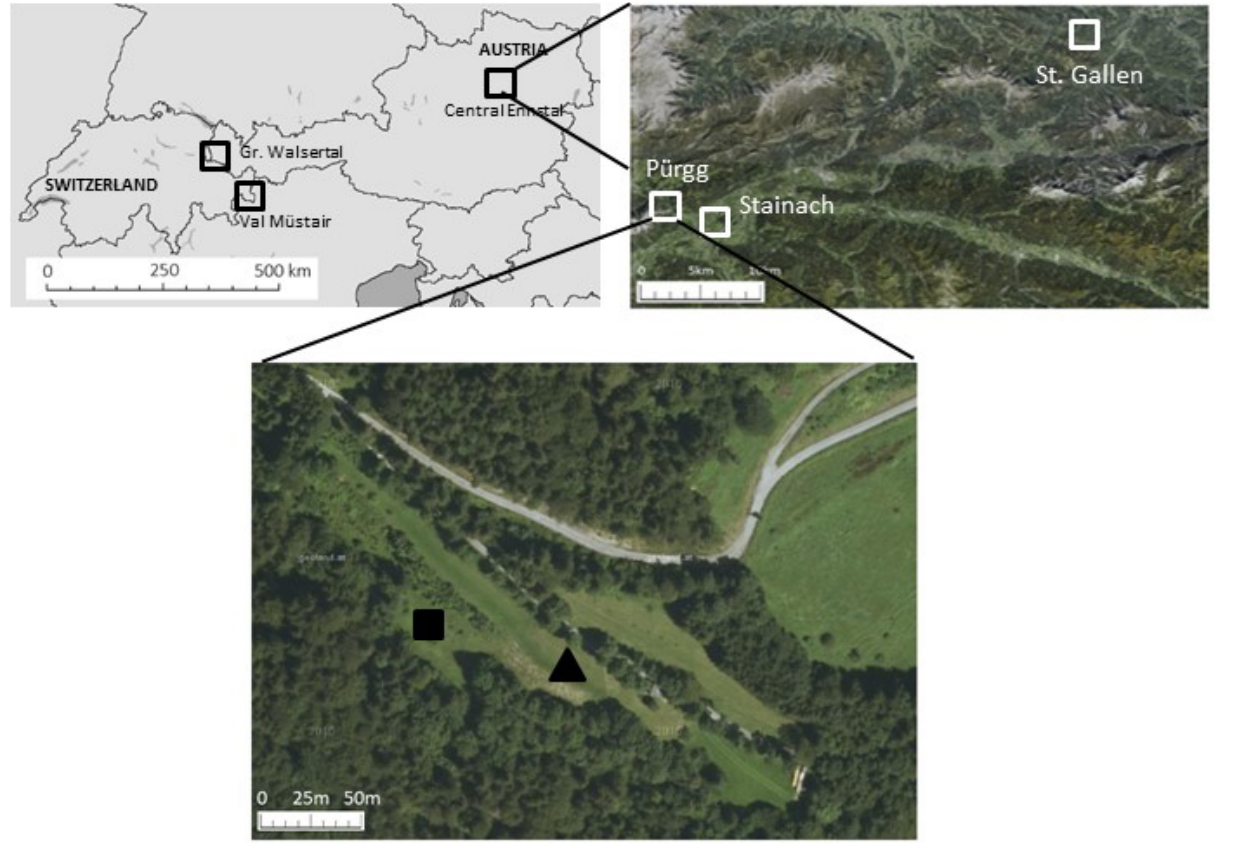
Figure 1. Location of the three study regions (central Ennstal, Großes Walsertal and Val Müstair). Detailed maps are shown for the central Ennstal region with the focus on two meadows in the municipality of Pürgg (the filled square outlines the location of one abandoned meadow, and the filled triangle outlines the location of one managed meadow). All panels are adapted from Basemap.at (2020), © data source: http://www.basemap.at (last access: April 2020), distributed under the Open Government Data Austrian license CC-BY